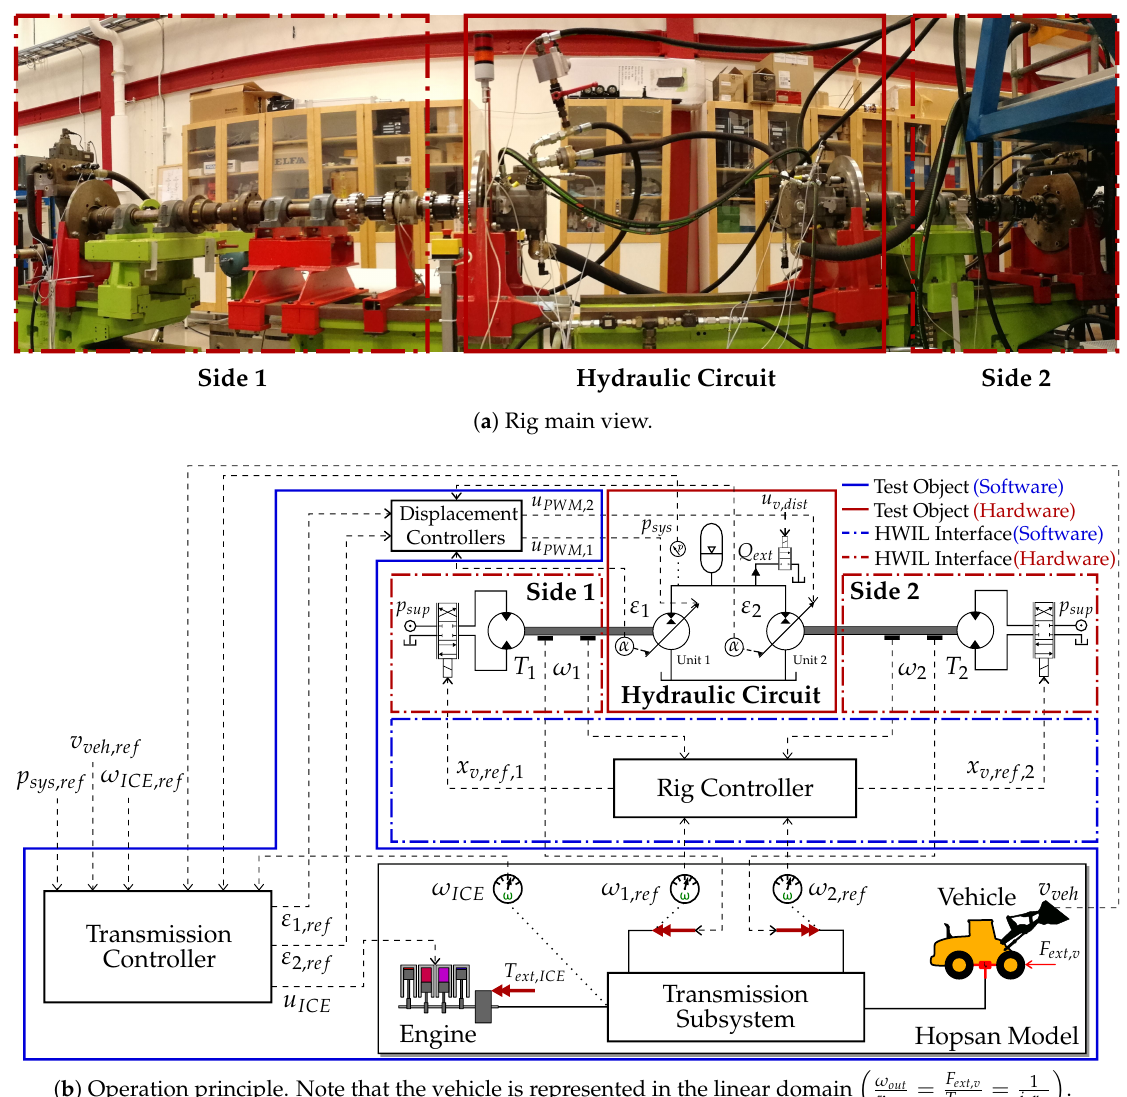
Figure 5. Overview of the HWIL test rig used in the